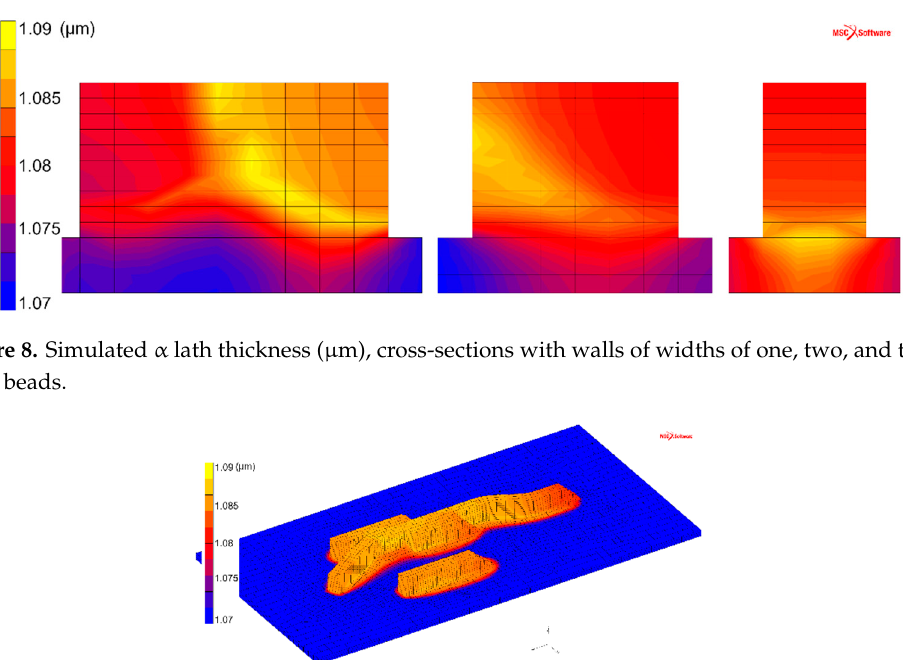
Figure 8. Simulated α lath thickness (µm), cross-sections with walls of widths of one, two, and three weld beads.